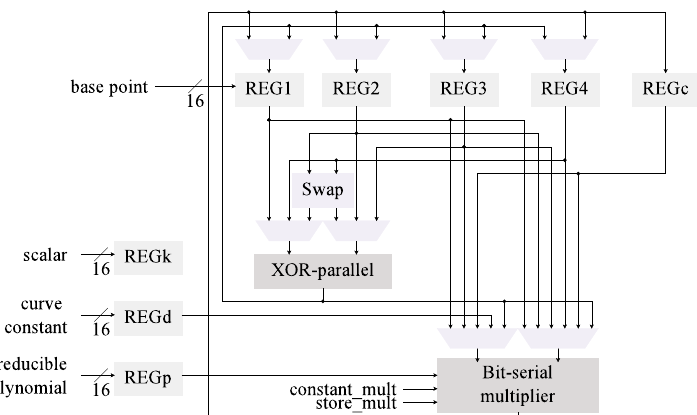
Figure 1. Low-area kP architecture, in the following referred to as